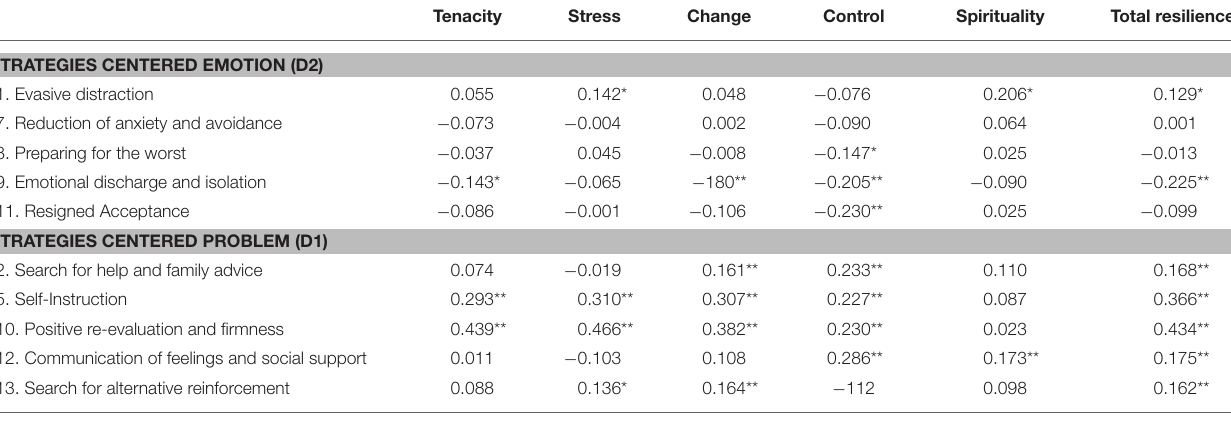
Table 4 | Bivariate correlations between Resilience factors and coping Strategies, ordered by dimensions and factors.